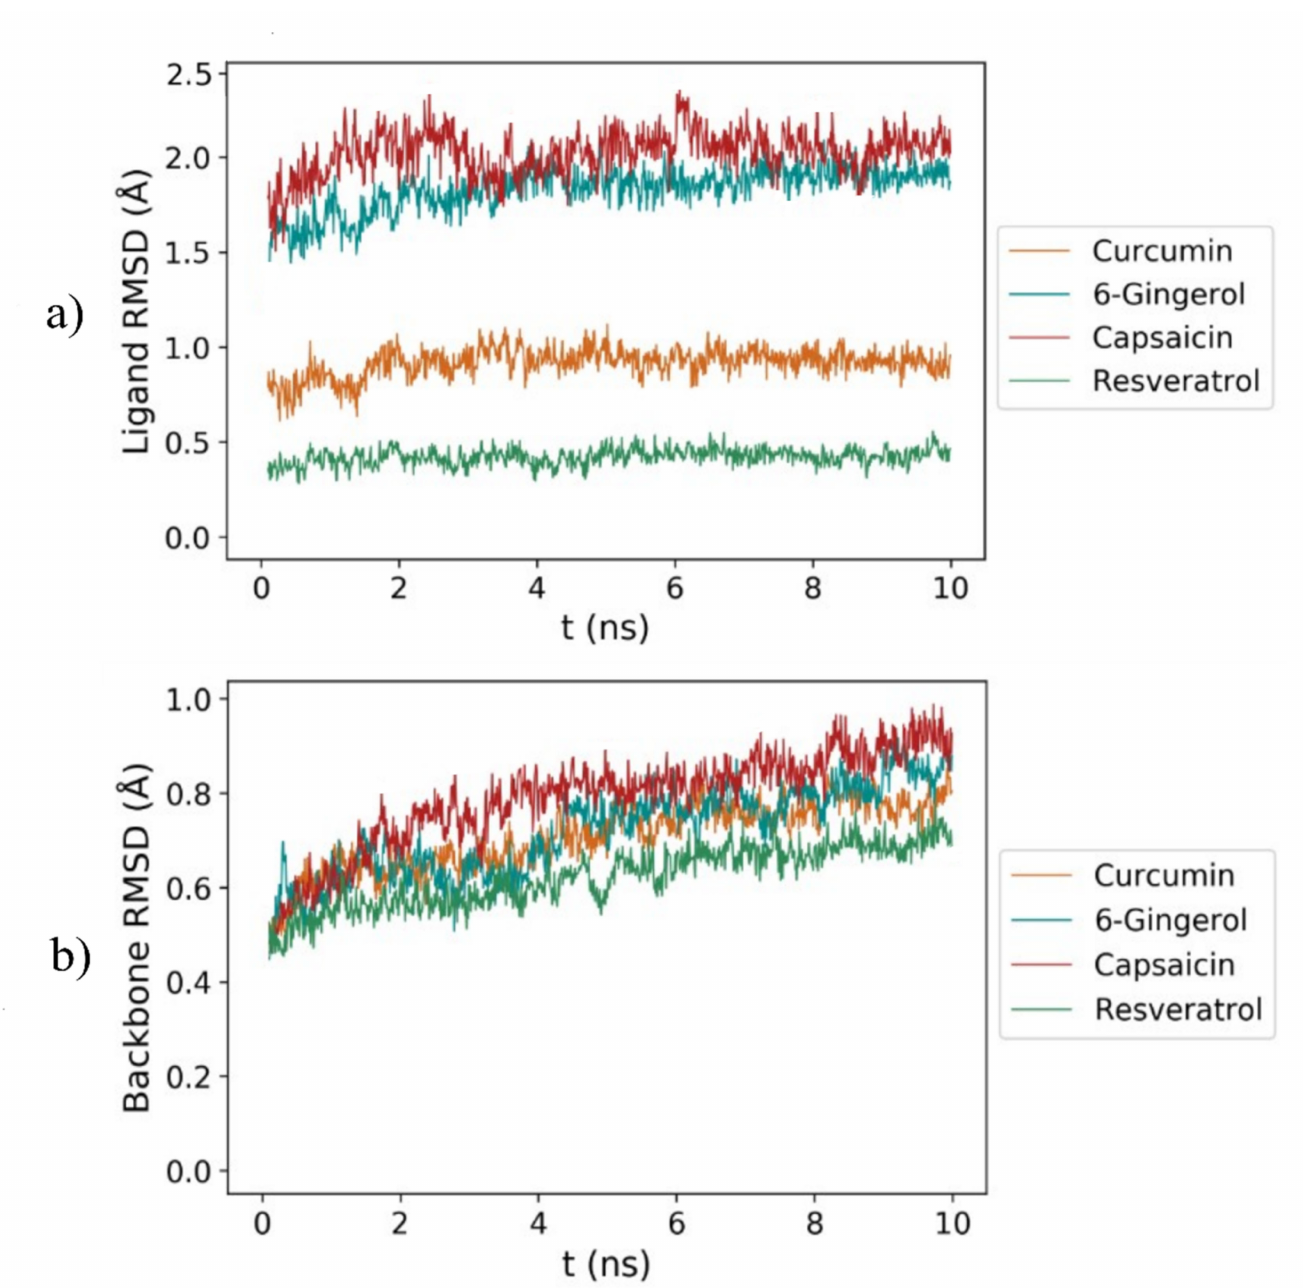
Figure 3. Root mean square deviation (RMSD) curves of ( a ) ligand atomic positions and ( b ) backbone atomic positions throughout 10 ns molecular dynamics simulations of four investigated systems: curcumin in complex with PDE4D (orange), 6-gingerol in complex with PDE4D (blue), capsaicin in complex with PDE4D (red), and resveratrol in complex with PDE4D